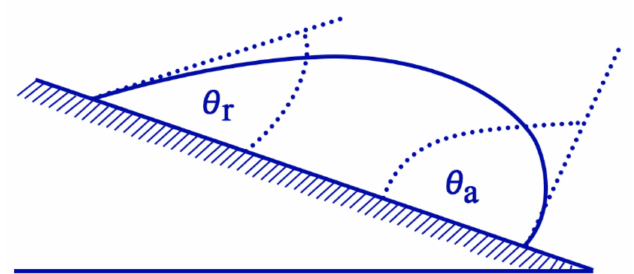
Figure 4. Schematic representation of advancing ( θ a ) and receding ( θ r ) contact angles on a tilted surface. Advancing contact angle can be referred to as a measure of solid–liquid cohesion, whereas receding contact angle can be referred to as a measure of solid–liquid adhesion. The difference between these angles is known as contact angle hysteresis, whereby a greater contact angle hysteresis indicates greater stickiness of the surface.